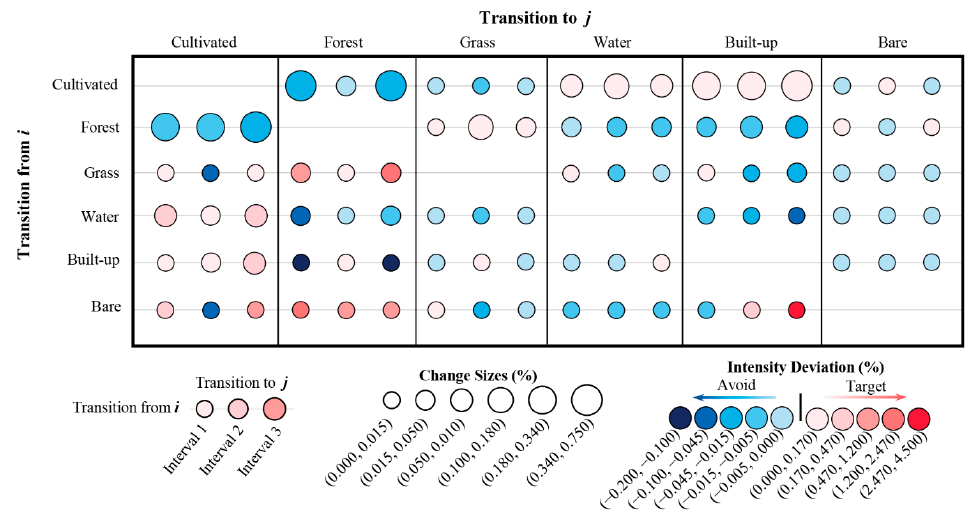
Figure 8. LULC change characteristic of mode in Hengyang from 1980–2015 (each bubble represents the transition from i to j at the interval; interval 1, interval 2 and interval 3 refer to the 1980–1995 period, 1995–2005 period and 2005–2015 period, respectively; intensity deviation = Rtin − Wtn).